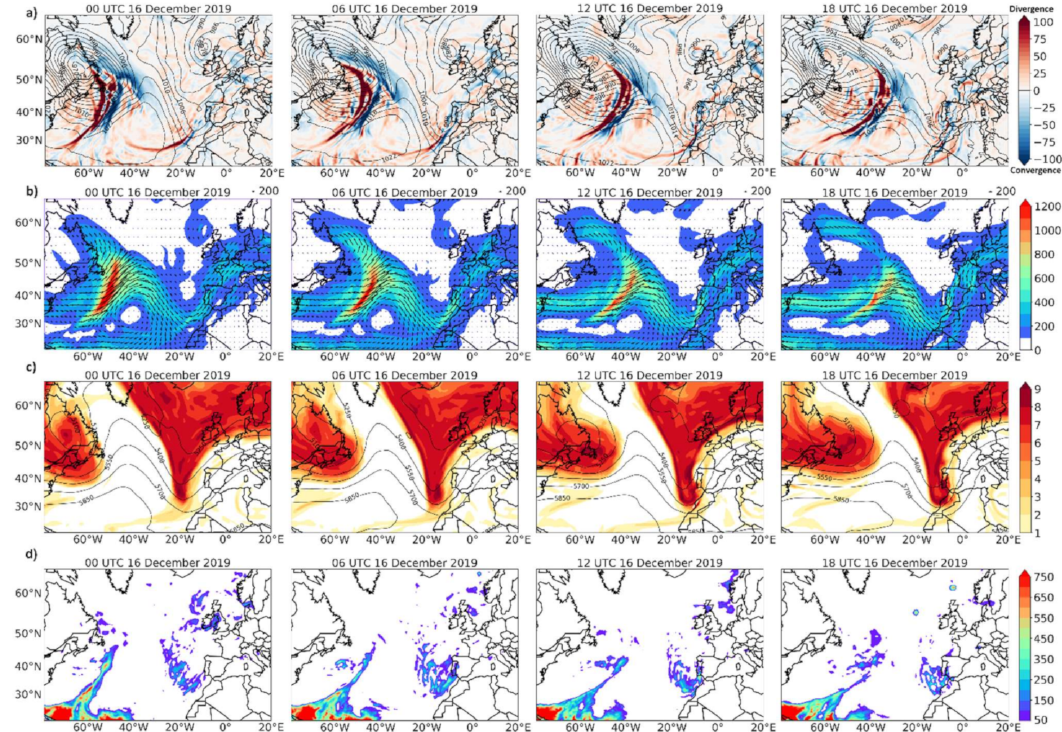
Figure 2. Analysis of the Daniel storm for 16 December 2019 (every six hours: 00, 06, 12, and 18 UTC). ( a ) VIMF (shaded, mm/day) and MSLP (contour, hPa). ( b ) IVT (kg/m*s, shaded) intensity and direction (vectors). ( c ) Potential vorticity at 250 hPa (shaded, PVU) and geopotential height at 500 hPa (contour, gpm). ( d ) Convective Available Potential Energy (CAPE) (shaded, J/kg).